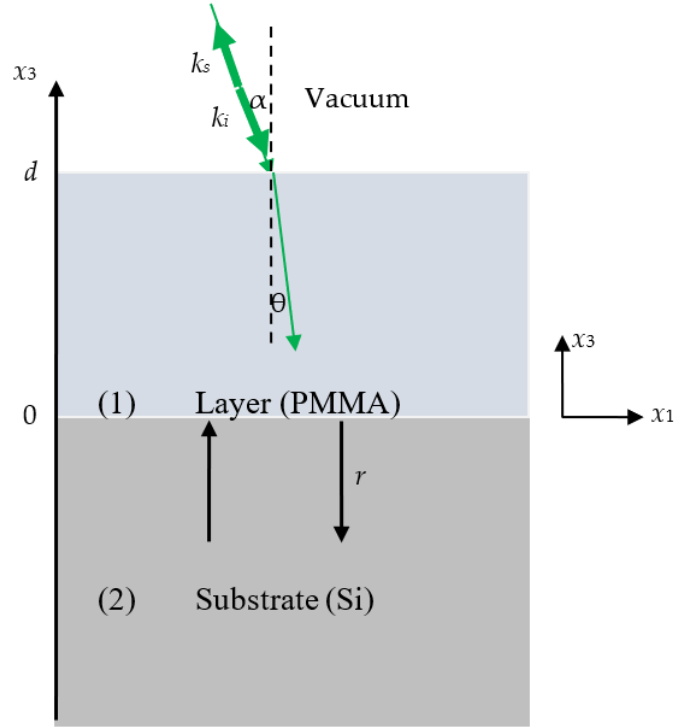
Figure 1. Schematic representation of one layer (labeled i = 1) of width d deposited on a substrate (labeled i = 2 ). The x 3 axis is normal to the surface. k i and k s are the incident and scattered wavevectors in vacuum. The electromagnetic fields are polarized along the x 2 axis. α and θ are the incident and refracted angles